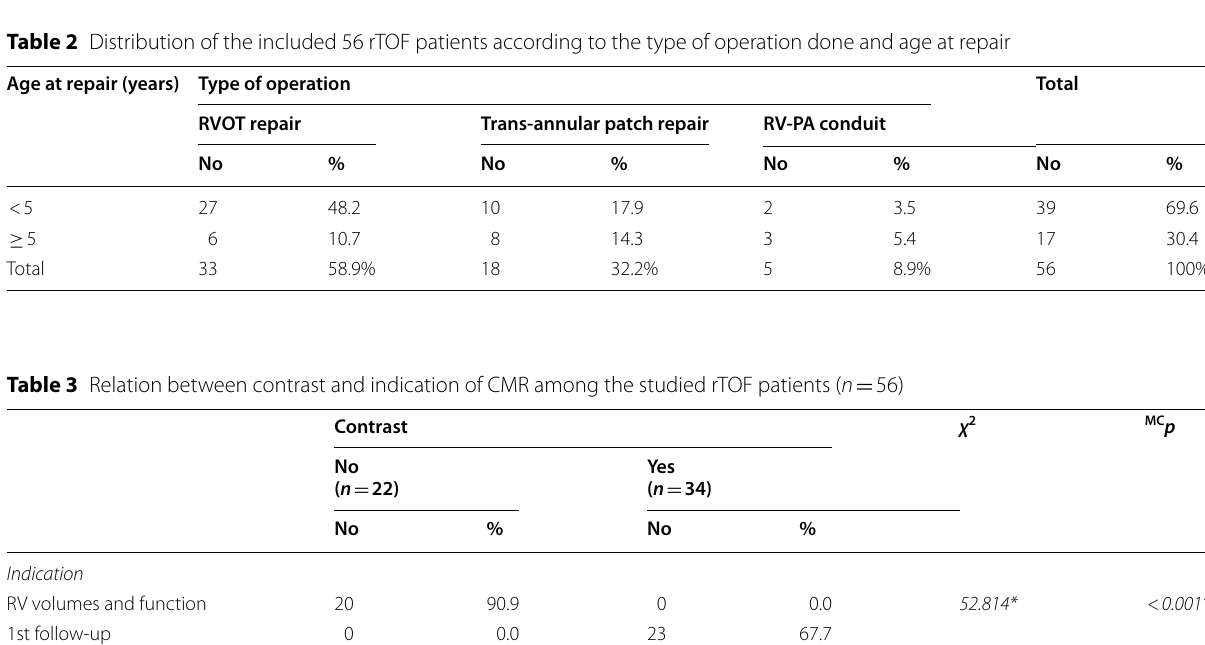
χ 2 : Chi-square test, MC Monte Carlo